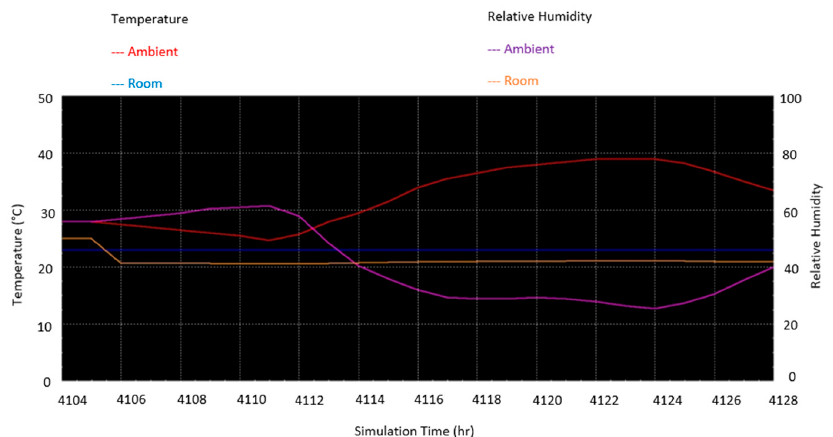
Figure 22. June 1st simulation run for option C.